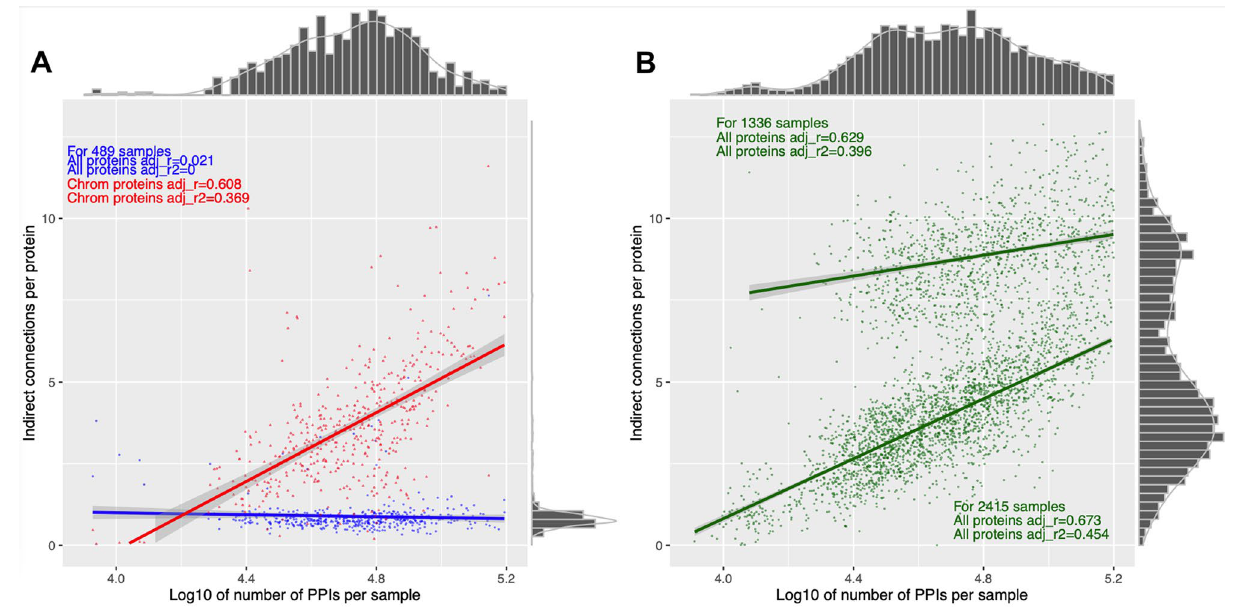
Figure 6. The number of PPIs per sample (x-axis) was positively correlated with the number of indirect connections per protein for ( A ) chromosomal (red, r = 0.61) but not all proteins (including plasmid-encoded ones, blue, r = 0.02) in the 489 samples with plasmid-encoded proteins. ( B ) The other samples with no plasmid- encoded proteins had positive correlations (green, r = 0.63 and r = 0.67) though with a bimodal pattern (groups of n = 2415 and n = 1336). The lines of best fit for each plot shows the linear correlation of the number of PPIs per sample with the number of indirect connections per protein. The histograms indicate the marginal densities per axis for each dataset.